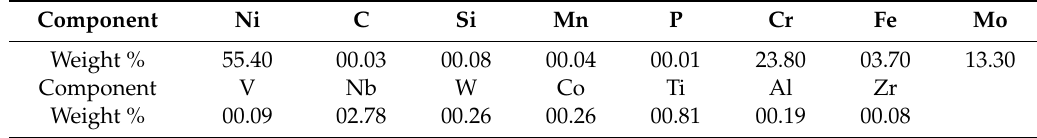
Table 2. Chemical composition of our work piece material (Inconel